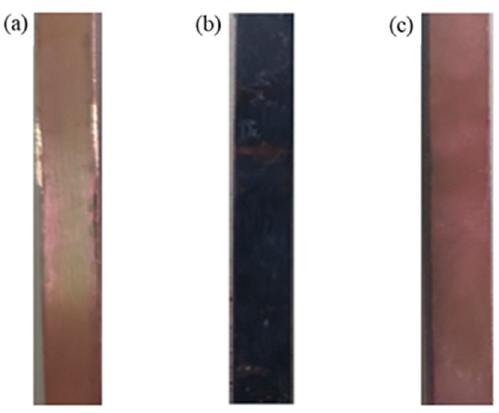
Figure 3. The color of copper surface at different stages. ( a ) before treatment; ( b ) after oxidation; ( c ) after chemical corrosion.